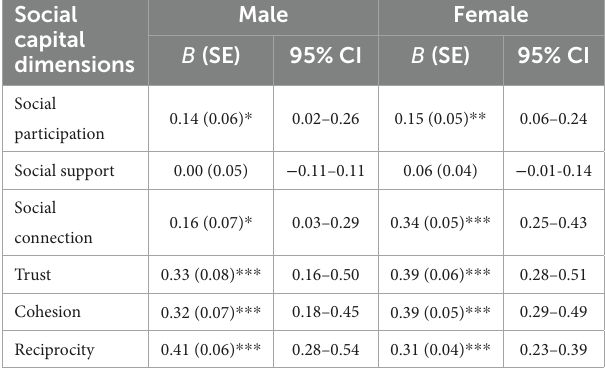
TABLE 5 The relationship between social capital and eHealth literacy among different genders.